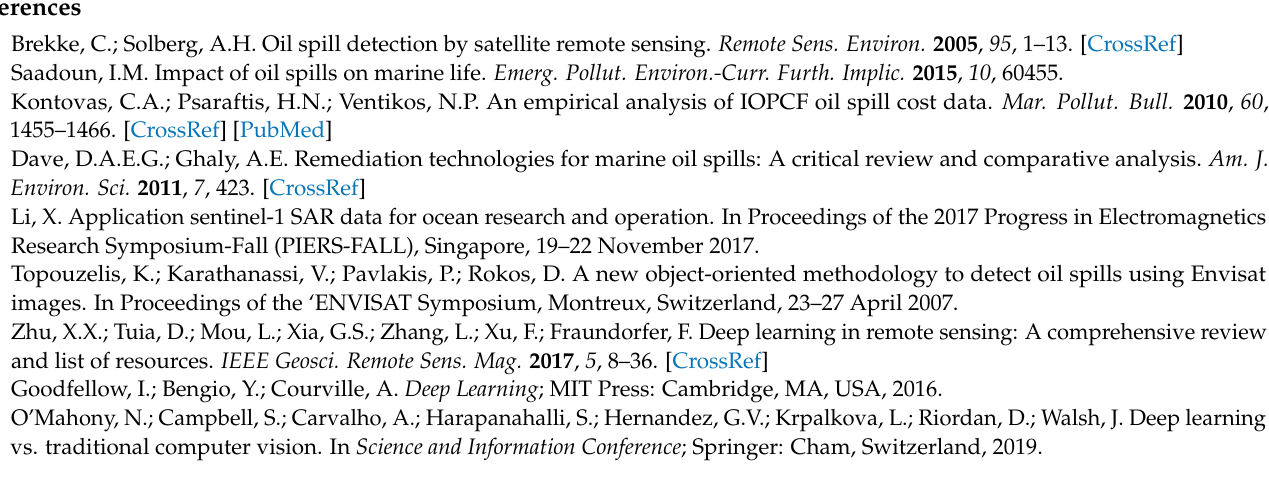
Figure 16. ( a ) Satellite image; ( b ) single ‘Oil Look-Alike’ type (red); ( c ) two ‘Oil Look-Alike’ types (red as Sharp and yellow as Patch Look-Alike).